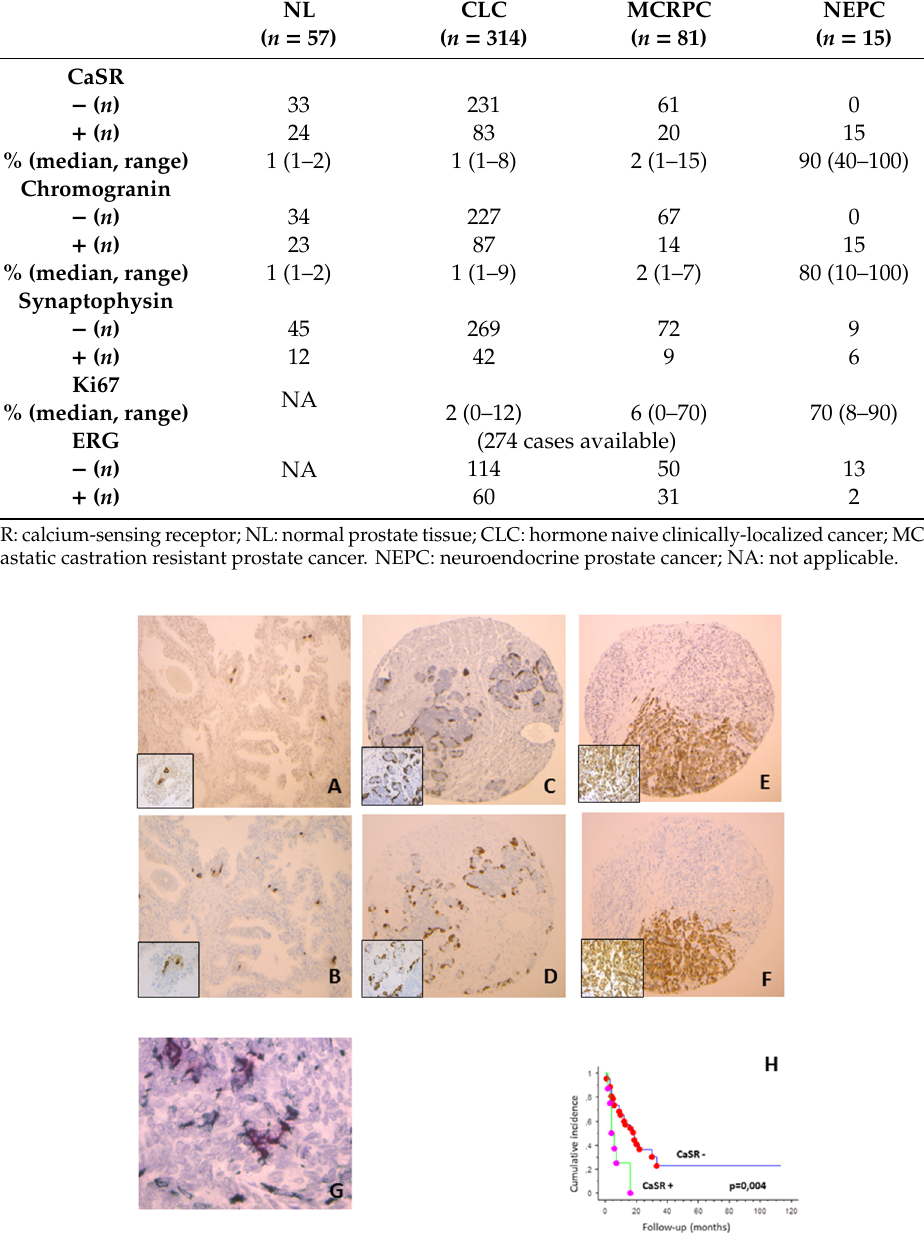
Figure 1. Immunostaining for calcium-sensing receptor (CaSR) ( A , C , E ) and chromogranin ( B , D , F ) on sequential slides. Both markers are expressed in the same areas of normal prostate tissue ( A , B , × 10; in inset × 40) and metastatic castration resistant prostate cancerv (MCRPC) ( C , D , × 5; in inset × 40). In case of mixed neuroendocrine prostate cancer (NEPC), only the neuroendocrine (NE) component expressed both CaSR and chromogranin ( E , F , × 5; in inset × 40). ( G ). Double immunostaining showing co-localization of CaSR and chromogranin in MCRPC. Cytoplasmic expression of chromogranin is shown as red; membranous staining of CaSR is shown as green. In some cells, CaSR was expressed without chromogranin staining ( × 60). ( H ). Kaplan-Meier overall survival in MCRPC patients, according to CaSR staining ( p = 0.004).